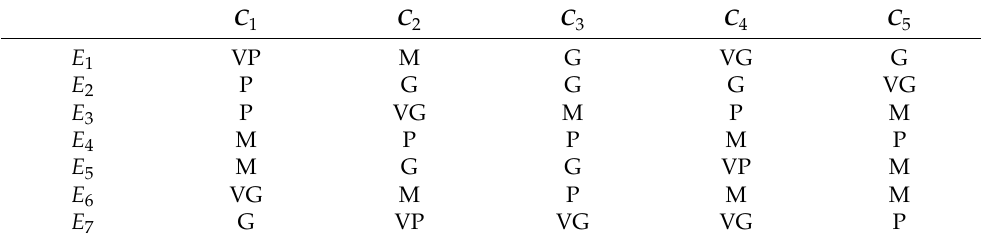
Table 5. Status value of criterion.